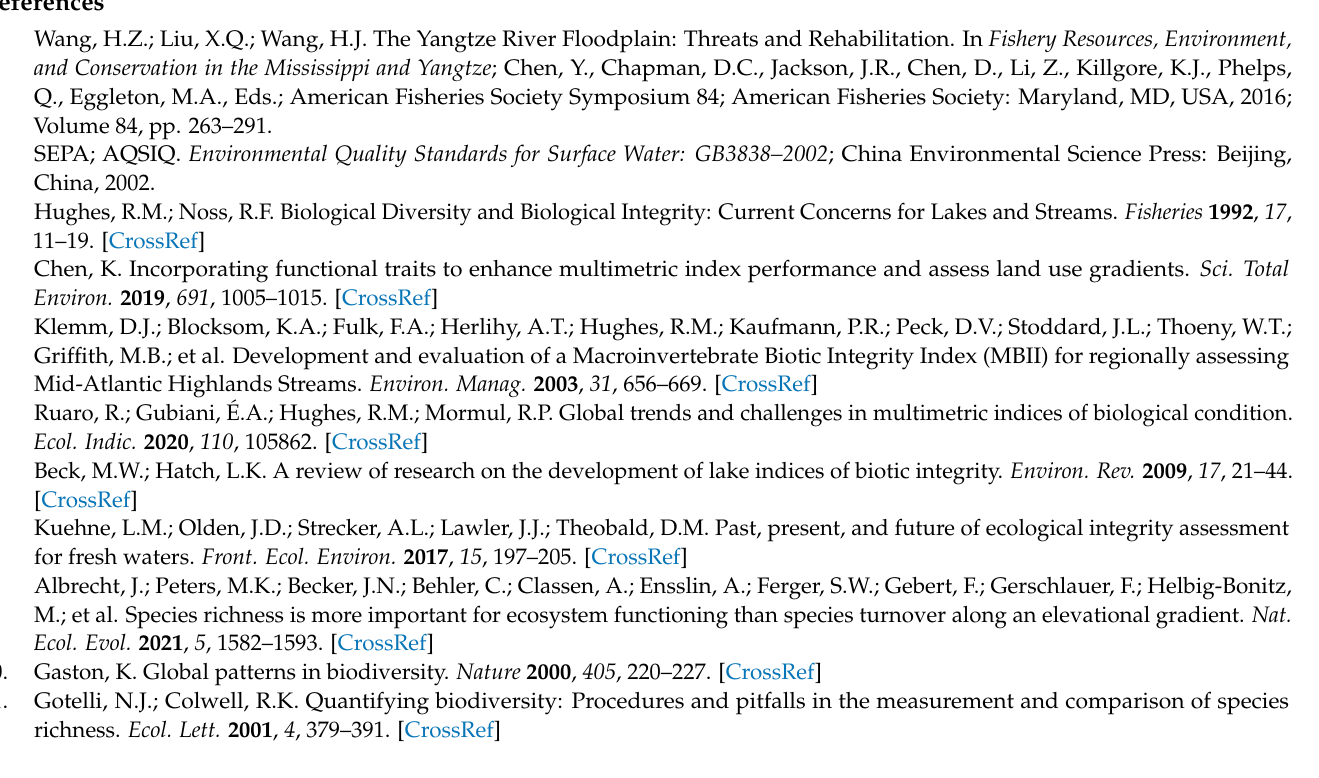
Figure S4. Quantile regressions of B-IBI index on total nitrogen (TN, mg/L), total phosphorus (TP, mg/L), chlorophyll a of phytoplankton (Chl a , µ g/L), Secchi depth (Z SD , m), annual submersed macrophytes biomass (B Mac , g/m 2 ) and ratio of Secchi depth to water depth (Z SD /Z M , m) (sample sizes differ because of deficient sampling). Figure S5. Quantile regressions of ASPT index on total nitrogen (TN, mg/L), total phosphorus (TP, mg/L), chlorophyll a of phytoplankton (Chl a , µ g/L), Secchi depth (Z SD , m), annual submersed macrophytes biomass (B Mac , g/m 2 ) and ratio of Secchi depth to water depth (Z SD /Z M , m) (sample sizes differ because of deficient